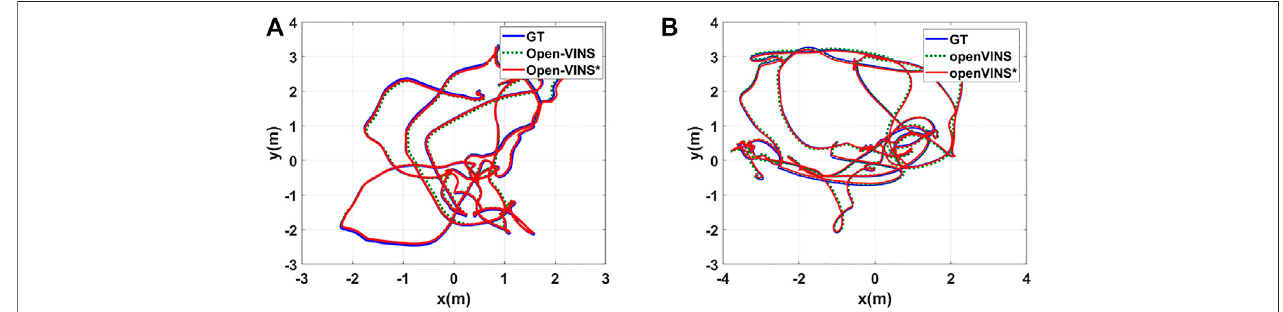
FIGURE5| PlotsofestimatedtrajectorieswithdifferentVIOmethods. (A) EstimatedtrajectoriesforsequenceV1_01_easy. (B) Estimatedtrajectoriesforsequence V2_02_medium. Open-VINS* takes the corrected IMU measurements from our proposed Calib-Net.